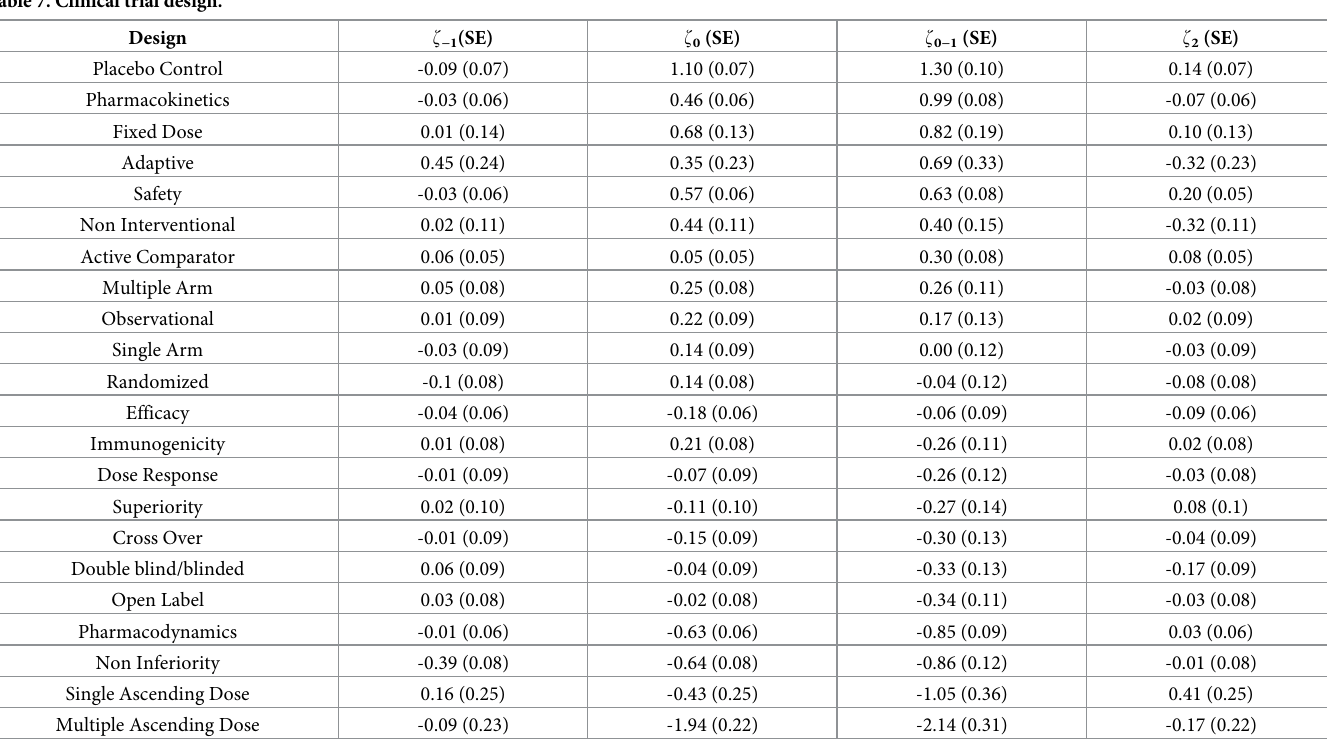
Table 7. Clinical trial